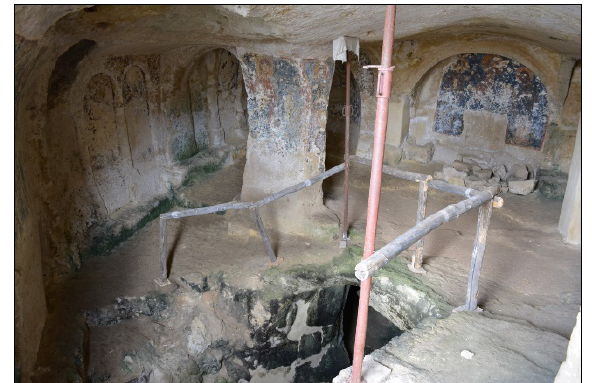
Figure 2. Upper level of the church – central apse and entrance the lower level.